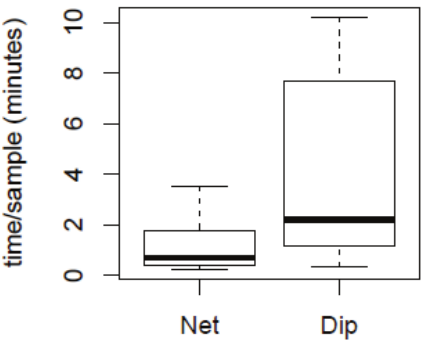
Figshare : Raw larval collection data for all 15 replicates, includ- ing the relative abundance of Anopheles and Culex collected and the estimated time taken to collect one larva for each replicate. 10.6084/m9.figshare.3123463 (Brisco et al. ,